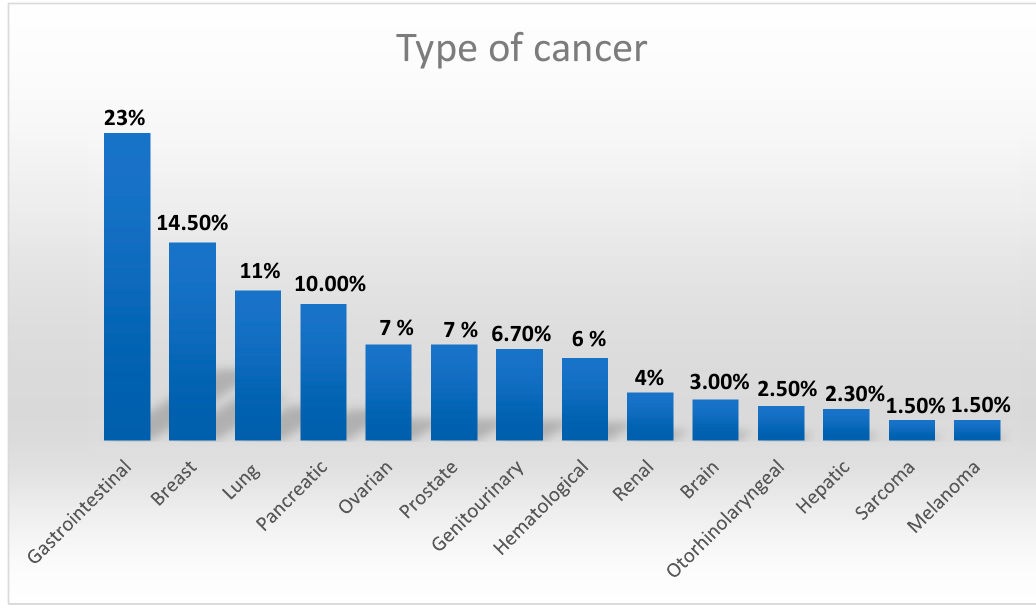
Figure 1. Different types of cancer in 131 enrolled patients.